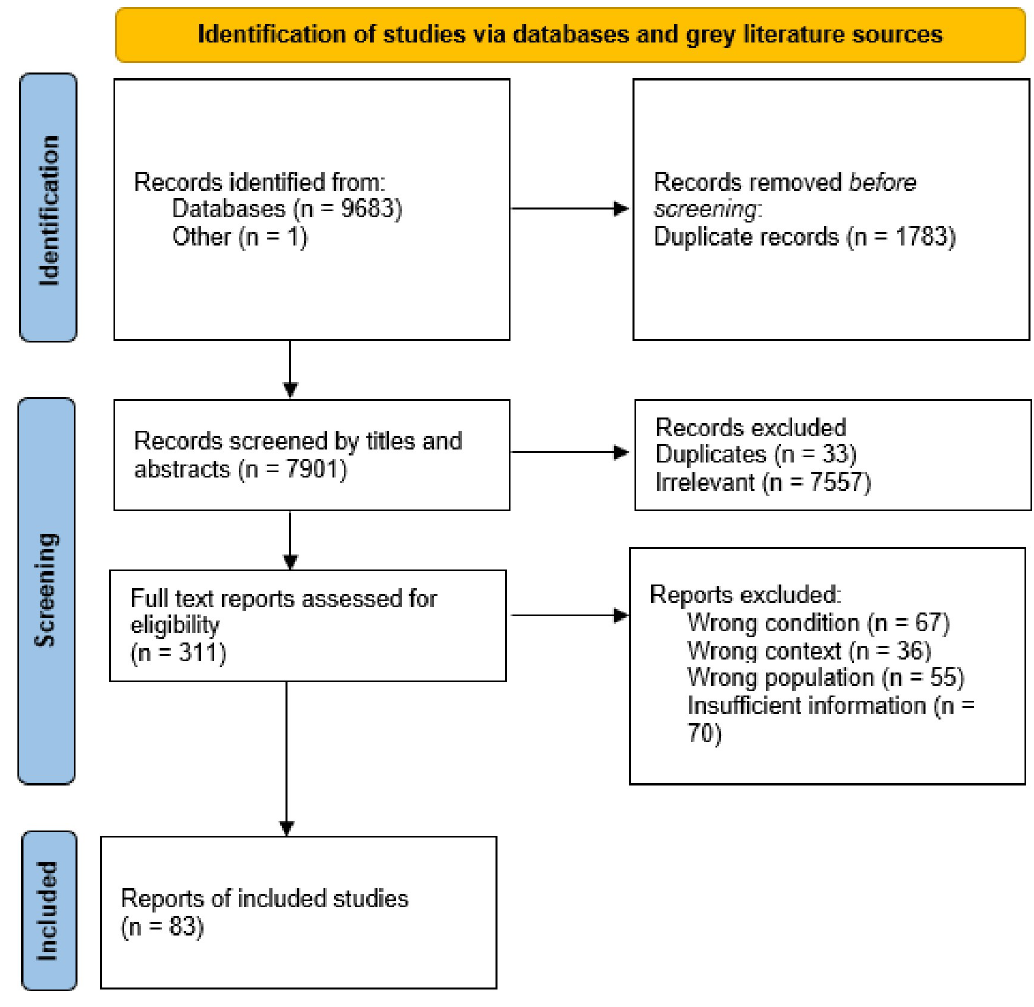
Fig 2. PRISMA flow chart depicting the screening